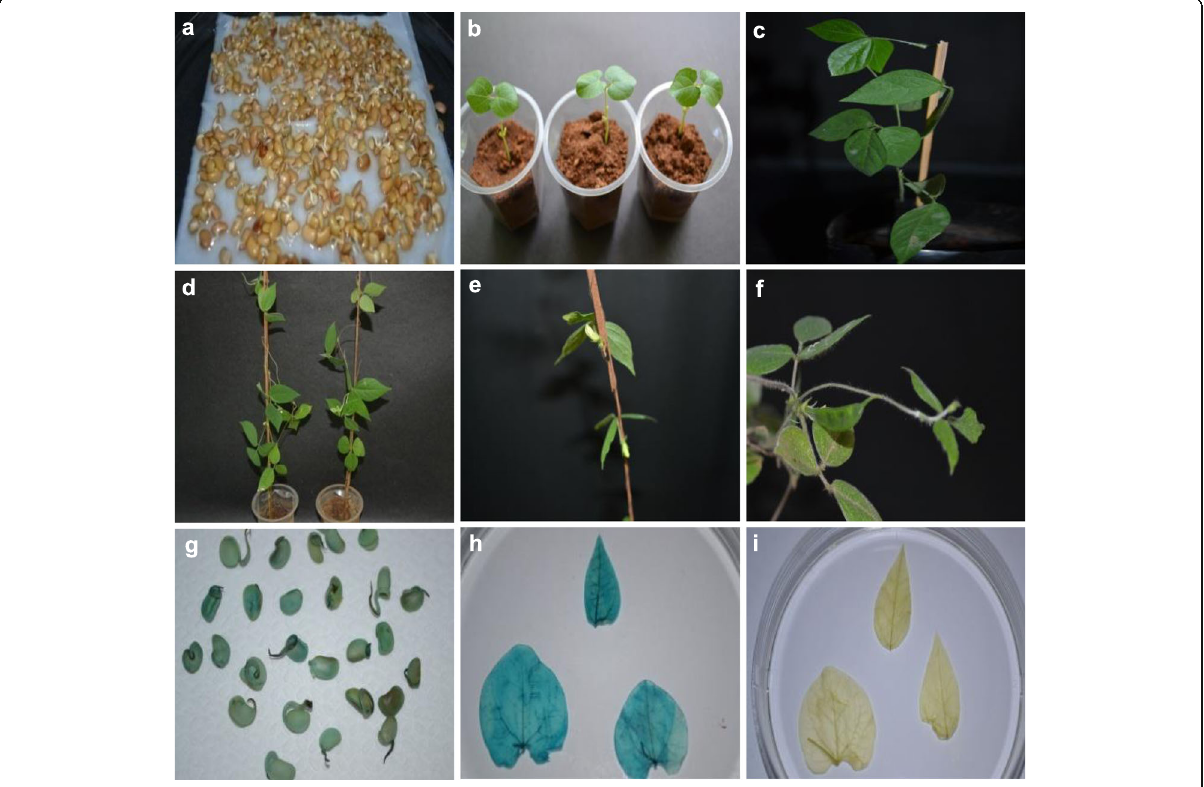
Fig. 2 In planta Agrobacterium -mediated genetic transformation of horse gram (var. Paiyur 2). a Germinated horse gram seeds used for the infection of Agrobacterium tumefaciens strain. b 7-day-old acclimatized putatively transformed plant. c 14-day-old acclimatized putatively transformed plant. d 50-day-old acclimatized putatively transformed plant by seedlings co-cultivated with Agrobacterium tumefaciens strain EHA105 harboring pCAMBIA2301 binary plasmid. e Putatively transformed plants shows the flowering. f Pod formation at 55 days. g GUS histochemical staining was performed in T 1 horse gram seedlings. h Leaves show GUS expression. i Non-transferred (control) plant leaves show no GUS expression at